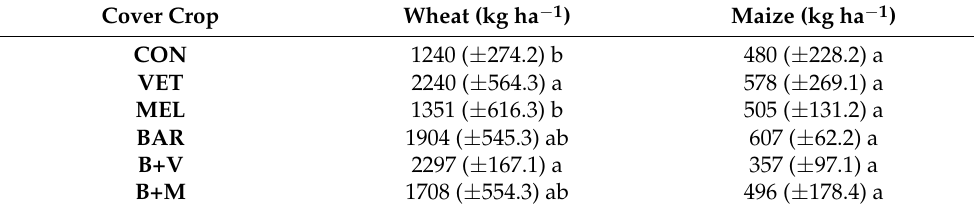
Table 4. Shoot dry biomass in cash crops after the different cover crops treatments. Cover